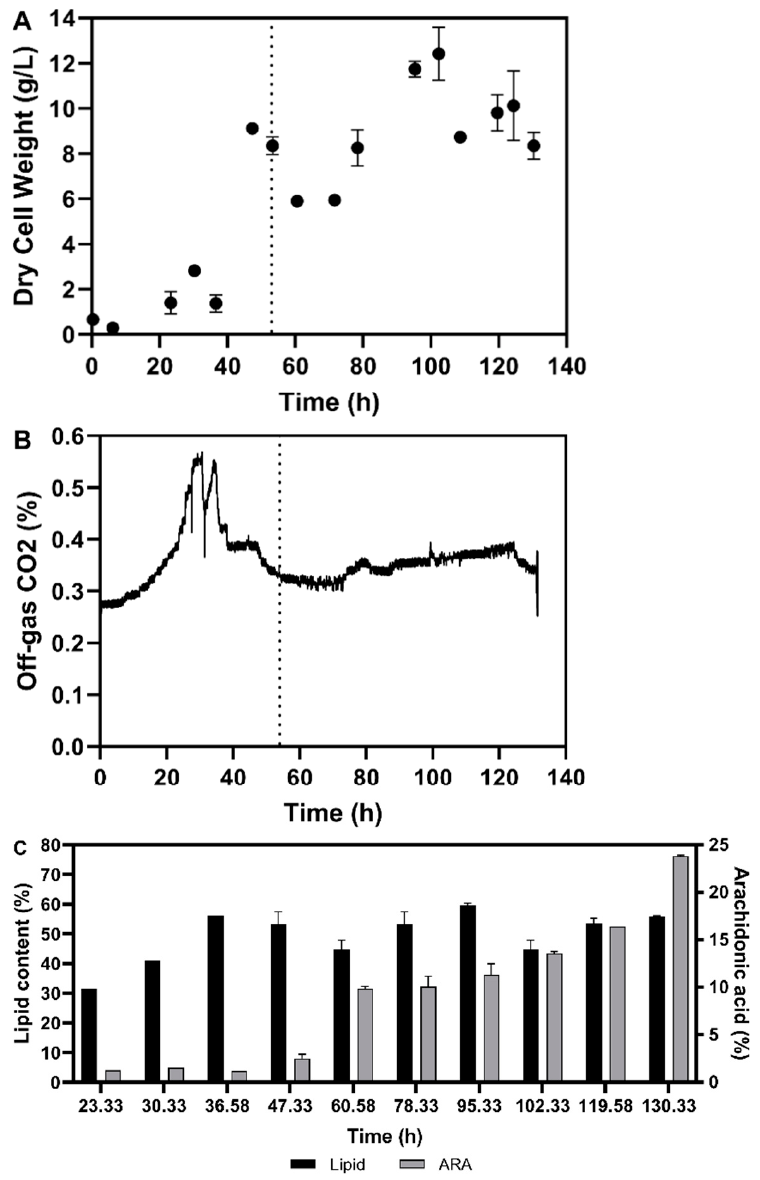
Figure 8. ( A ) Dry cell weight, ( B ) off-gas CO 2 profile, and ( C ) total lipid content (% wt of dry cell weight) and arachidonic acid (ARA) content (% wt of total lipid weight) obtained during fed-batch cultivation of M. alpina in fermenter using animal fat waste. The dotted vertical line indicates the beginning of feed phase.